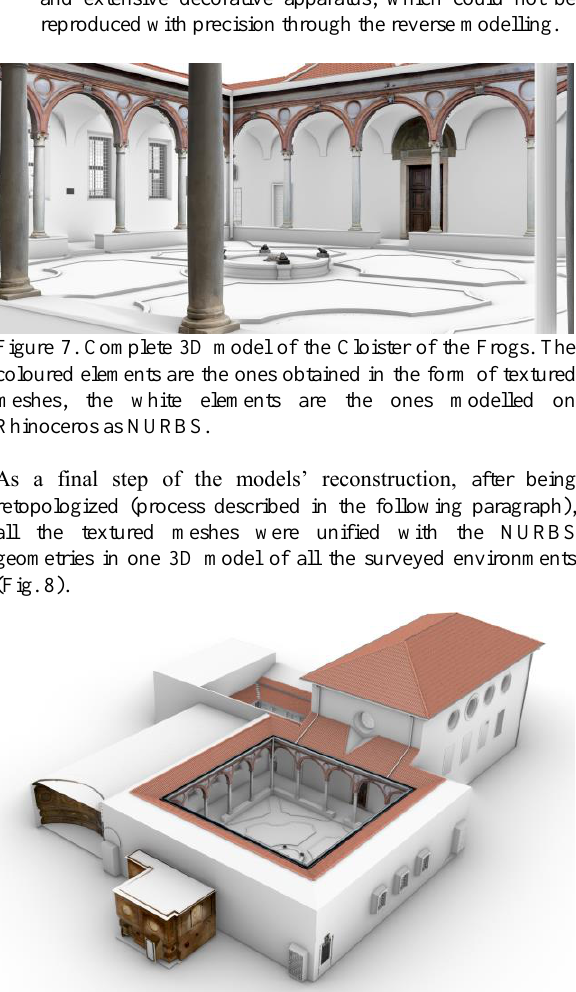
Figure 8. Complete 3D model displayed on Rhinoceros. The coloured elements are the ones obtained in the form of textured meshes, the white elements are the ones modelled on Rhinoceros as